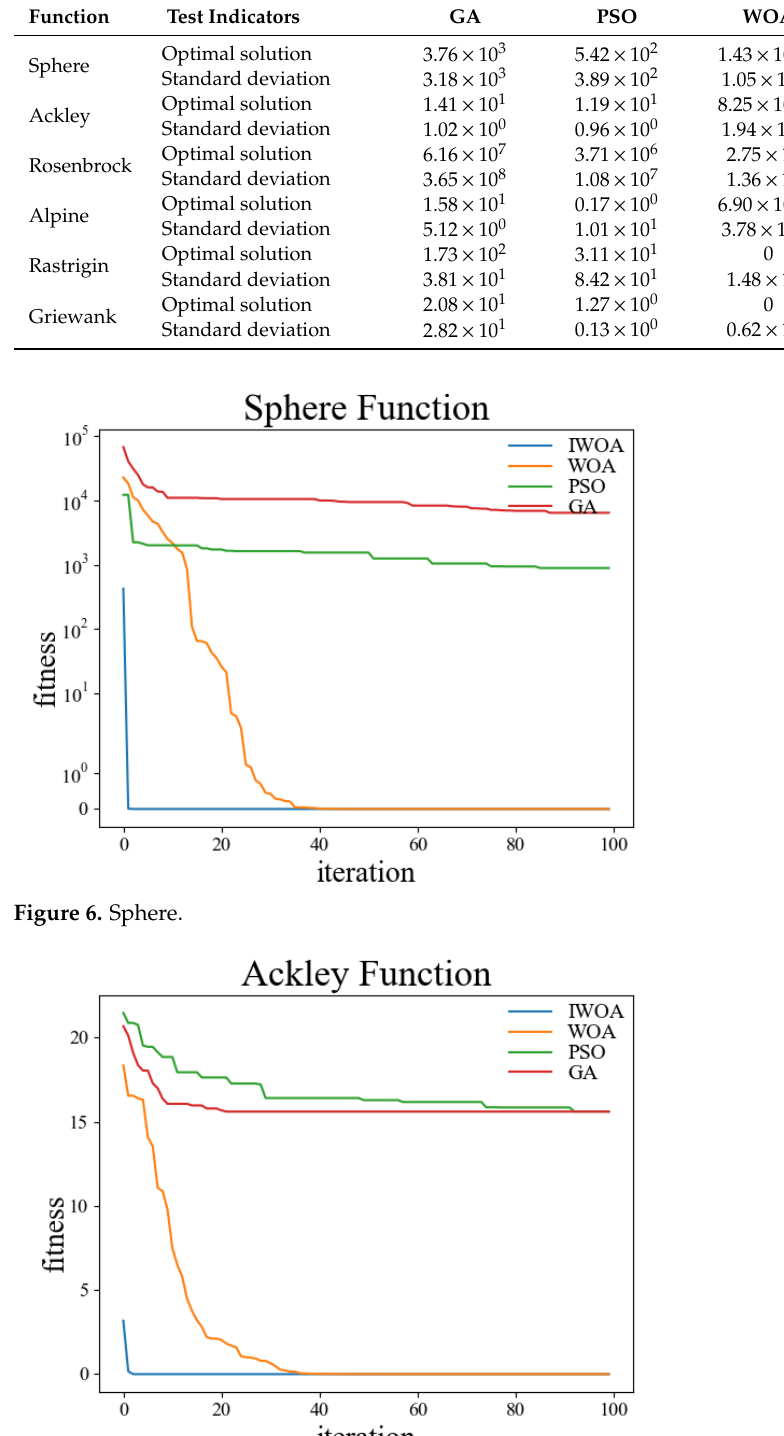
Table 2. Comparison of test function results.